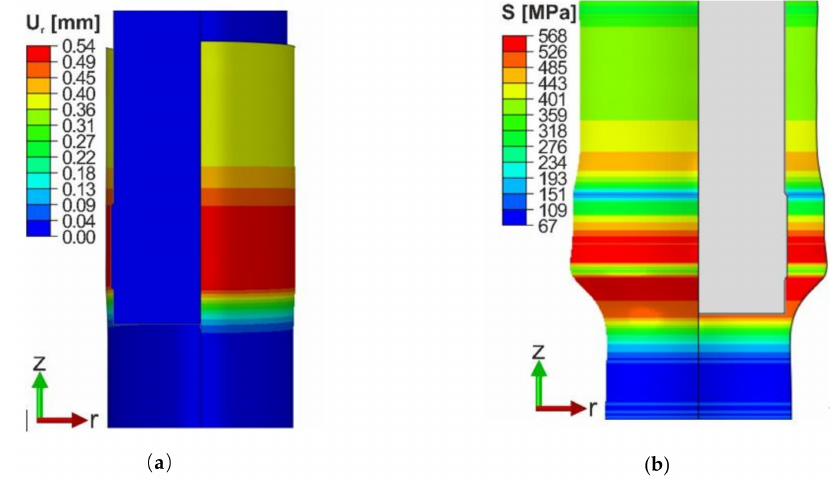
Figure 9. The contour lines of r-displacement (FEM): ( a ) Displacement; ( b ) Von-Mises Stress.